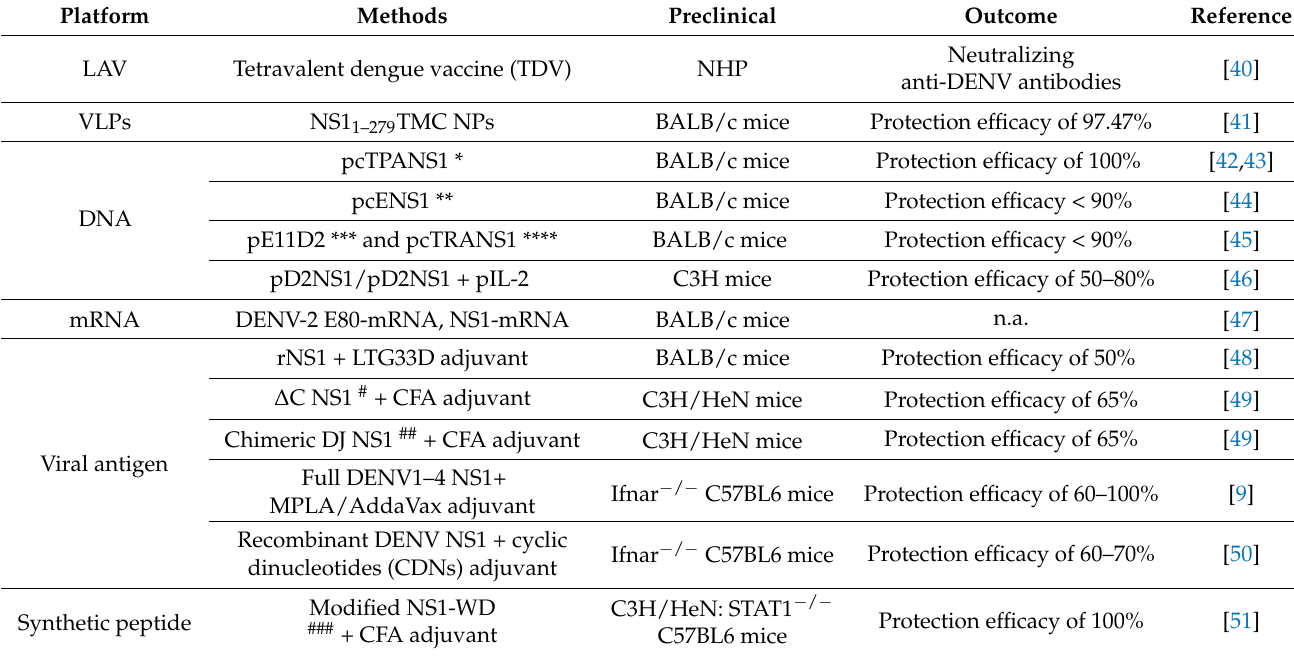
Table 1. Different NS1-based vaccine